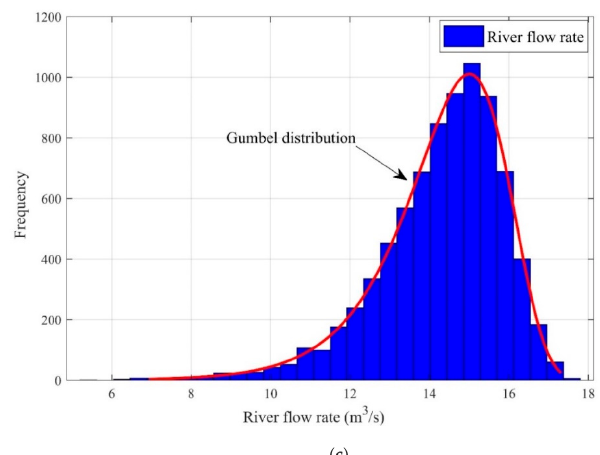
Figure 4. Probability density functions (PDFs): ( a ) Weibull distribution of wind speed, ( b ) Lognormal distribution of solar irradiance, and ( c ) Gumbel distribution of river flow rate.